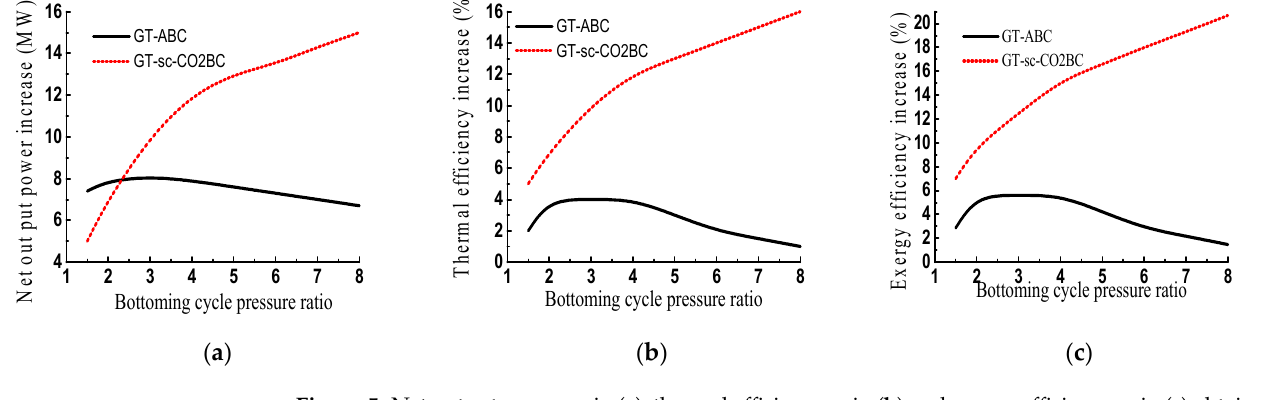
Figure 5. Net output power gain ( a ), thermal efficiency gain ( b ) and exergy efficiency gain ( c ) obtained with GT-ABC and GT-sc-CO 2 BC compared with ASC versus pressure ratio (ambient temperature = 25 °C and gas mass flow rate = 390 kg/s).